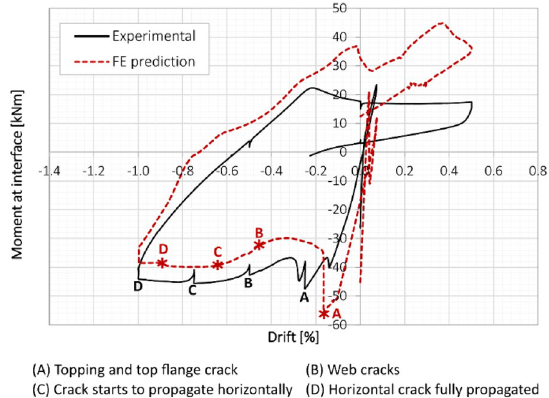
Fig. 9 Comparison of the numerical and experimental drift versus moment at the beam–unit interface